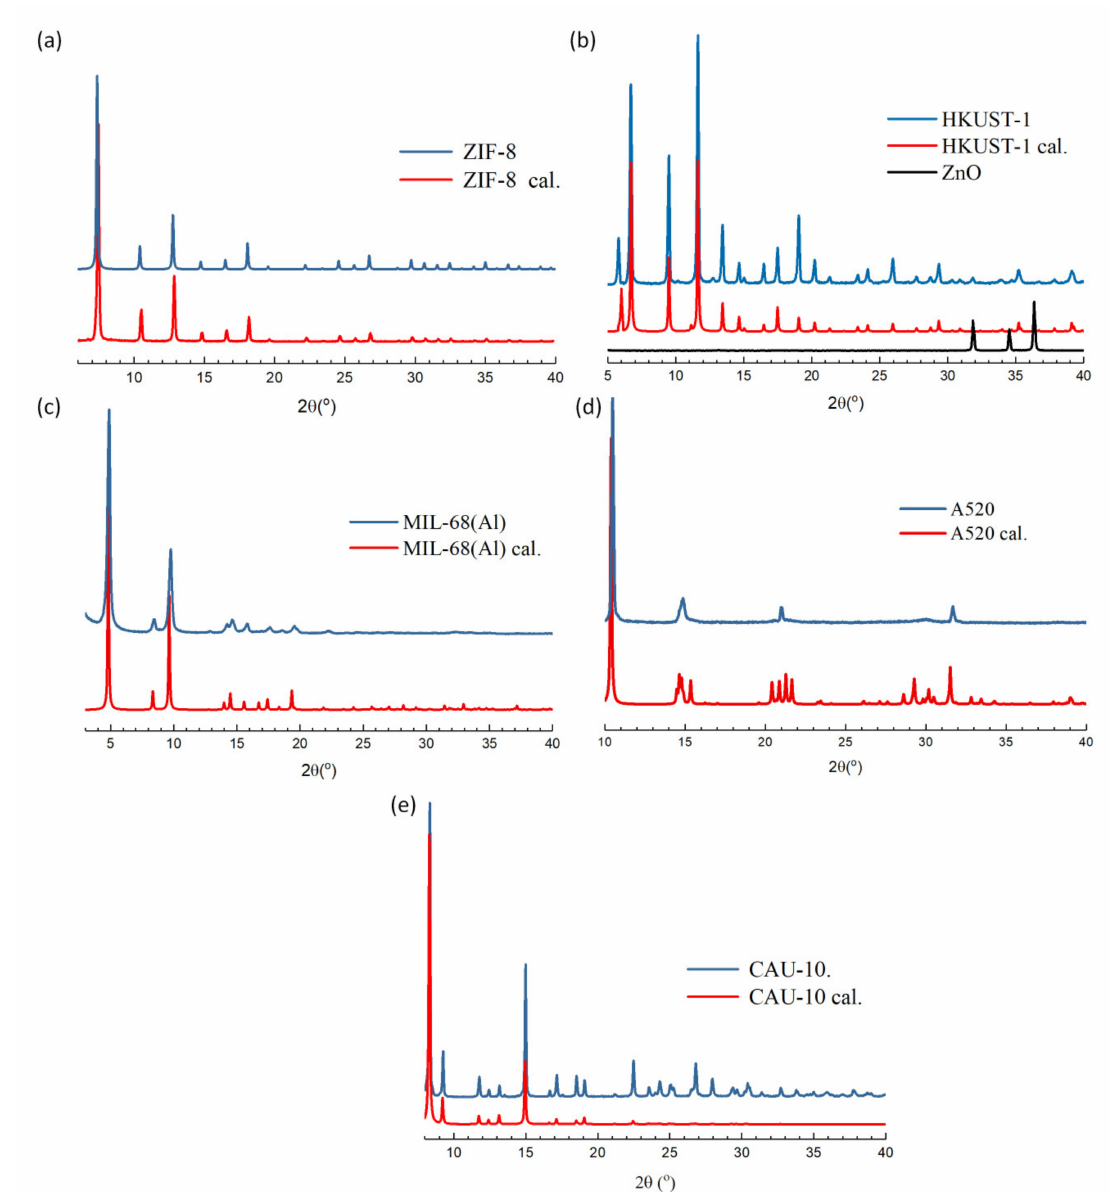
Figure 1. Powder pattern of ( a ) ZIF-8, ( b ) HKUST-1, ( c ) MIL-68(Al), ( d ) A520, and ( e )